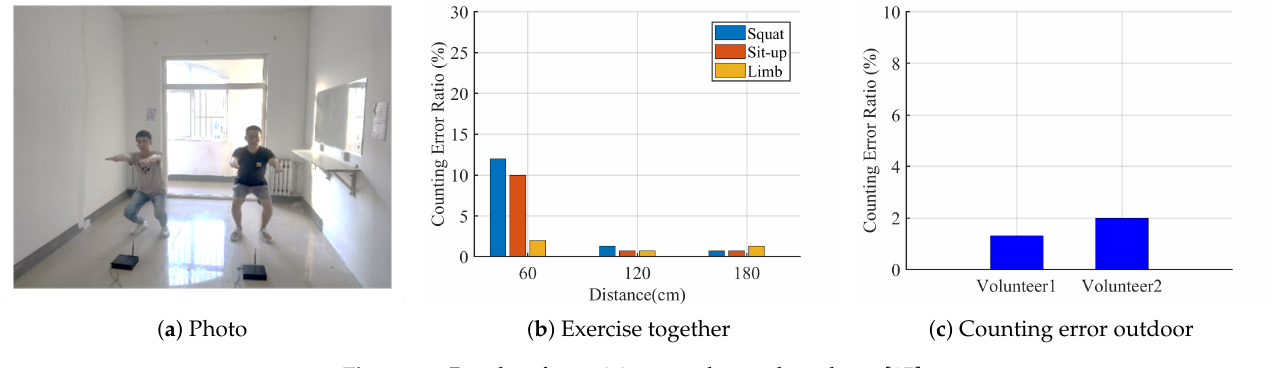
Figure 23. Results of exercising together and outdoors